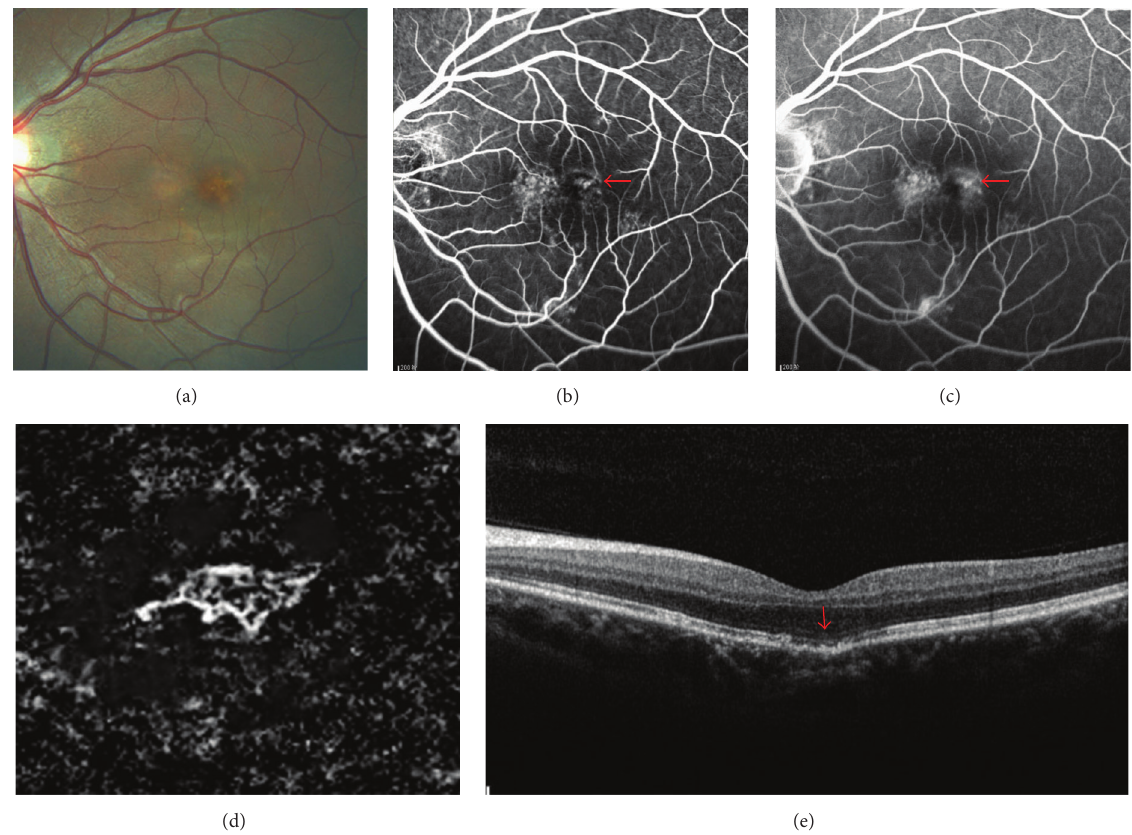
Figure 4: Multimodal imaging of neovascularization in age-related macular degeneration. (a) A color fundus photograph image from a 50- year-old male patient who complained of the reduced vision for one week displaying the presence of drusen in the subfoveal. (b) Early-frame FA showing hyperfluorescence in the region of CNV (red arrow). (c) Late-frame FA image showing leakage and pooling (red arrow). (d) A 3 ∗ 3 -mm En face angiogram of the outer retina demonstrating a small well-circumscribed CNV in the subfoveal surrounded by a halo of choriocapillaris vessels. (e) Spectral-domain optical coherence tomography (SD-OCT) only showing drusen, disrupted of retinal pigment epithelium (RPE), and small defect of the photoreceptor layer which were graded as dry AMD (red